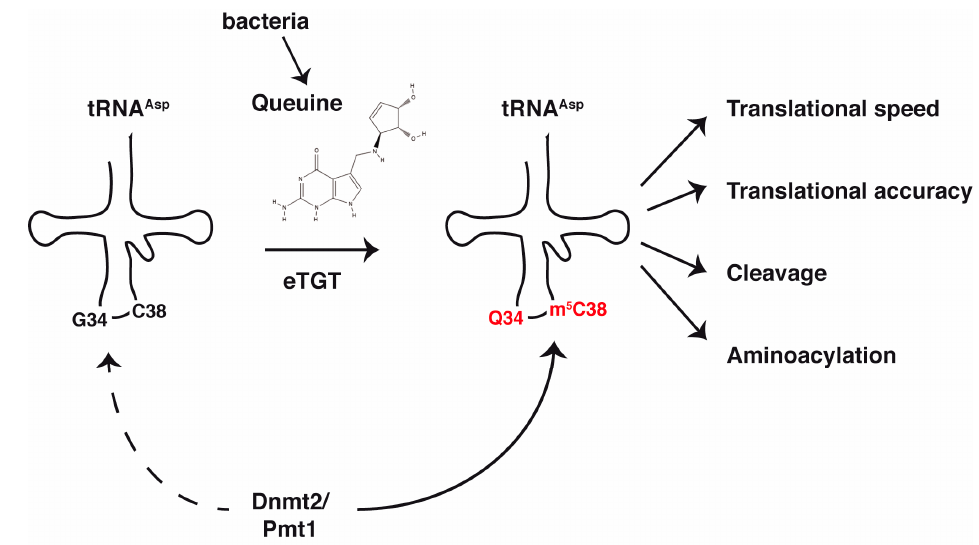
Figure 1. Stimulation of Dnmt2 activity in S. pombe (Pmt1) by prior Q incorporation. Dnmt2/Pmt1 shows low activity on non ‐ Q ‐ modified tRNA Asp (dashed arrow), but is highly active on Q ‐ modified tRNA Asp . Right, possible consequences of dual Q and m 5 C38 modification. eTGT: eukaryotic TGT enzyme.